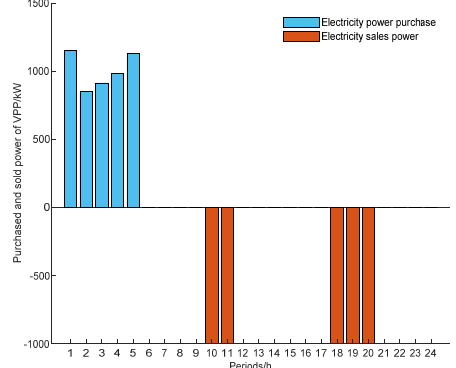
Figure 7. The actual and expected power of the demand response load.